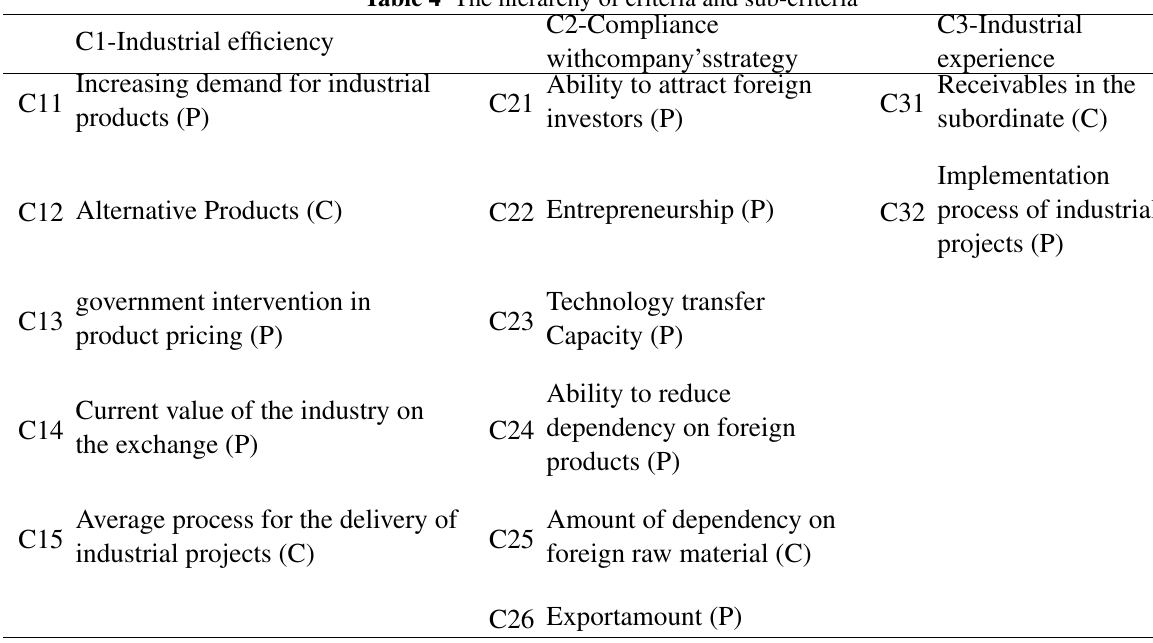
Table 4 The hierarchy of criteria and sub-criteria